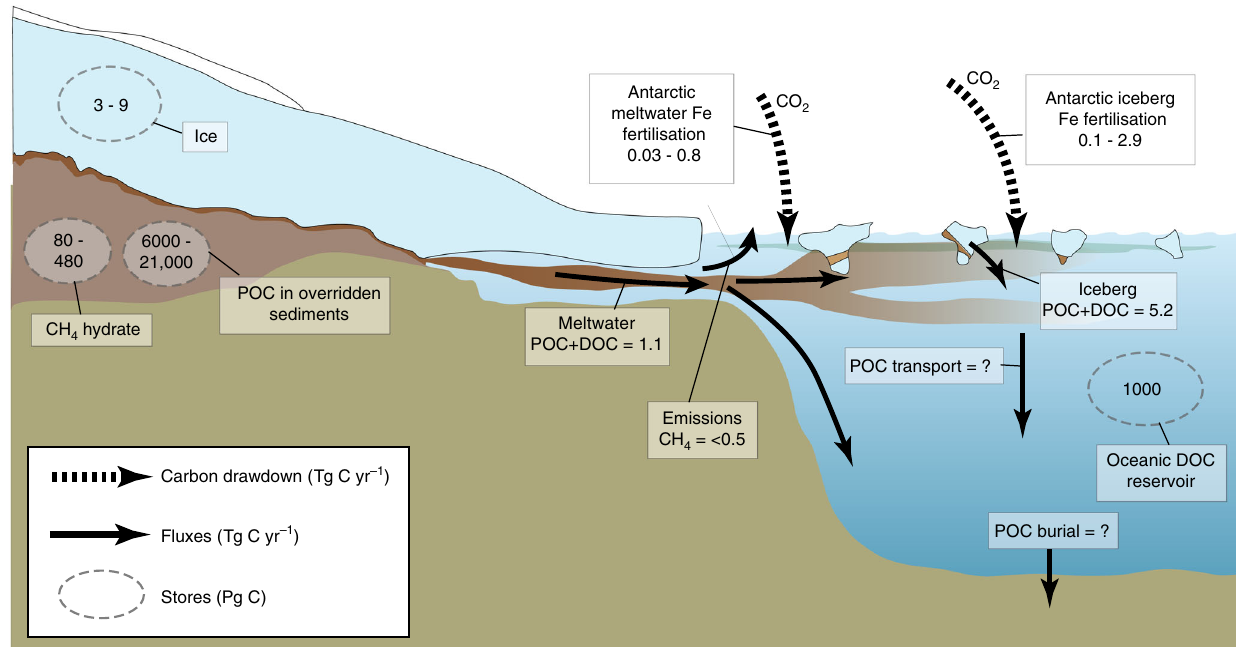
Fig. 7 Stores and fl uxes in present day ice sheets. A summary diagram indicating stores and fl uxes of nutrients for present day ice sheets, and the predicted impact on CO 2 (where data exists). The estimated size of carbon stores (Pg C) and Fluxes (Tg a − 1